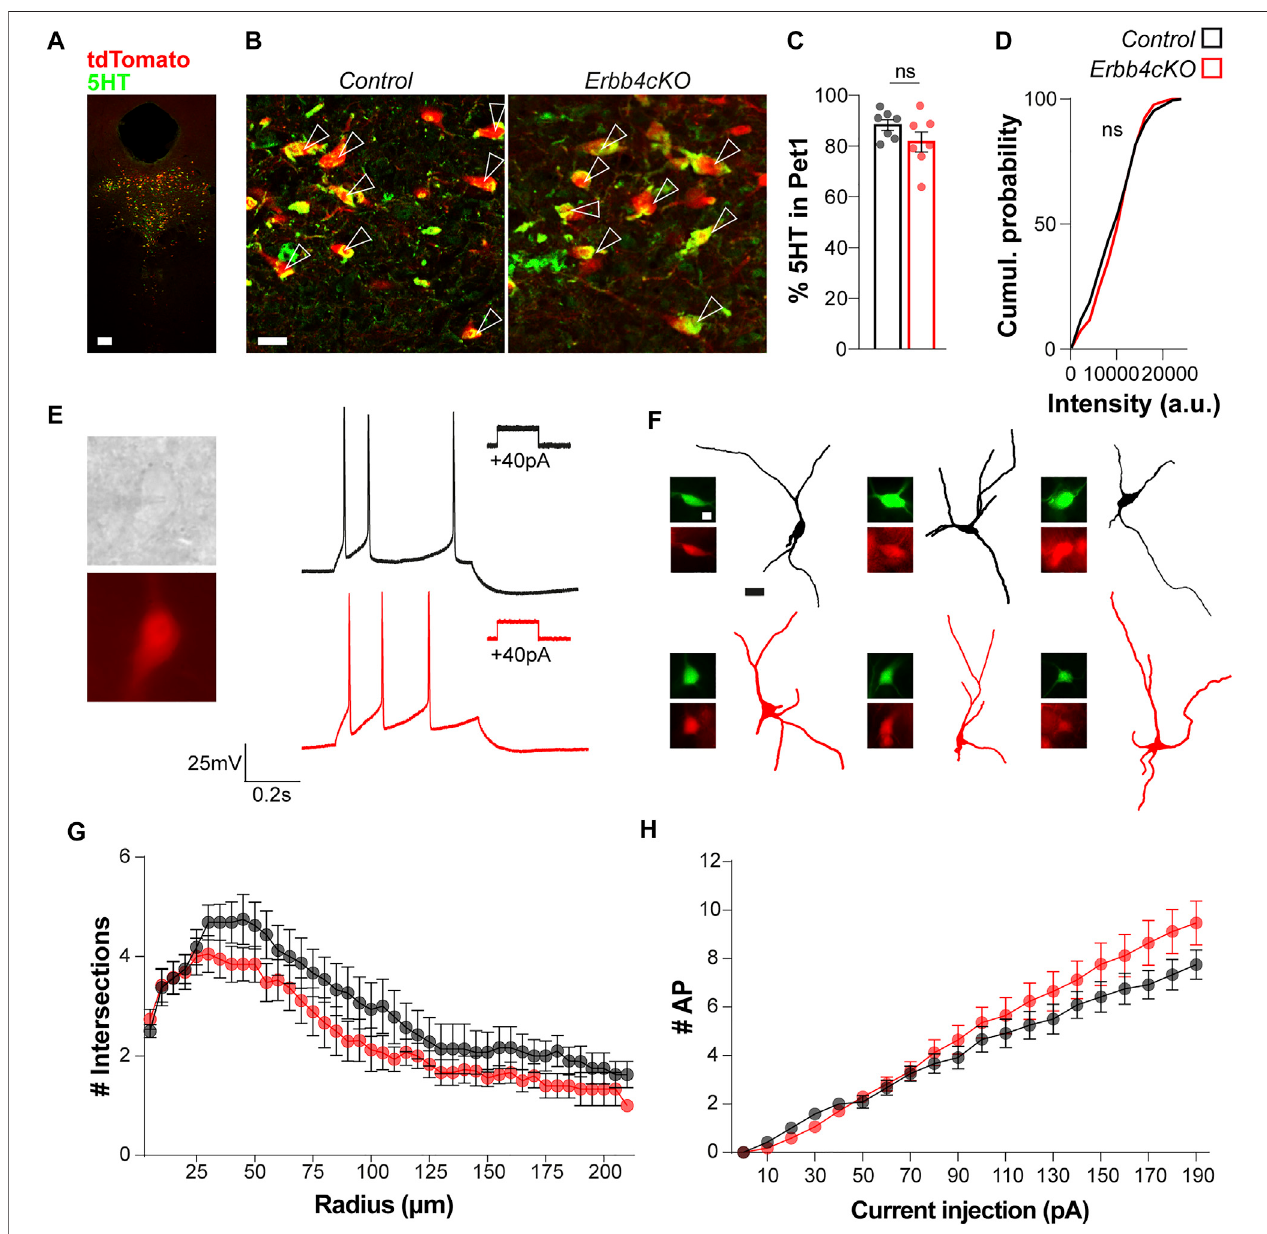
FIGURE 4 | ErbB4 de fi ciency in Pet + neurons does not lead to changes in global excitability or serotonin content in the DRN in male mice. (A) Colocalization of Pet1 -tdTomato and 5HT in the raphe nucleus. (B) Magni fi cations for the colocalization of Pet1 -tdTomato and 5HT in control and Erbb4cKO mice. Arrow heads point to doublepositivecellsfor Pet1 and5HT. (C) Quanti fi cationofthepercentageof Pet1 +cellsexpressing5HT( n (cid:2) 7controland n (cid:2) 7mutantmicefrom4differentlitters). (D) Cumulative probability of 5HT intensity for control and Erbb4cKO cells expressed as arbitrary units (n (cid:2) 5 control and n (cid:2) 5 mutant mice from 3 different litters). (E) Representative images and traces of Pet1 + tdTomato-expressing neurons recorded in current clamp mode in control (black) and Erbb4cKO (red) mice. (F) Reconstructionsof Pet1 +cellsrecorded.Imagesofstreptavidin-Alexa488(green)andtdTomato(red)foreachcell. (G) Shollanalysisof Pet1 +tdTomato+cellsrecorded for control and Erbb4cKO mice.Intersectionsarequanti fi ed per radius of5 µm ofdifference from soma ( n (cid:2) 11neurons from3differentcontrol mice and n (cid:2) 16neurons from 3different mutant mice). (H) Input-output plotshowing number ofspikes asa function of injected current displayed by Pet1 + tdTomato+ neurons in control ( n (cid:2) 11 neurons from 3 different control mice) and Erbb4cKO mice ( n (cid:2) 16 neurons from 3 different mutant mice). Scale bars in (A) : 100 and 20 µm and (F) 10 and 25 µm. Data are represented as mean ± SEM. ns: not signi fi cant differences. t-test, Kolmogorov-Smirnov test or two-way ANOVA with Bonferroni correction for multiple